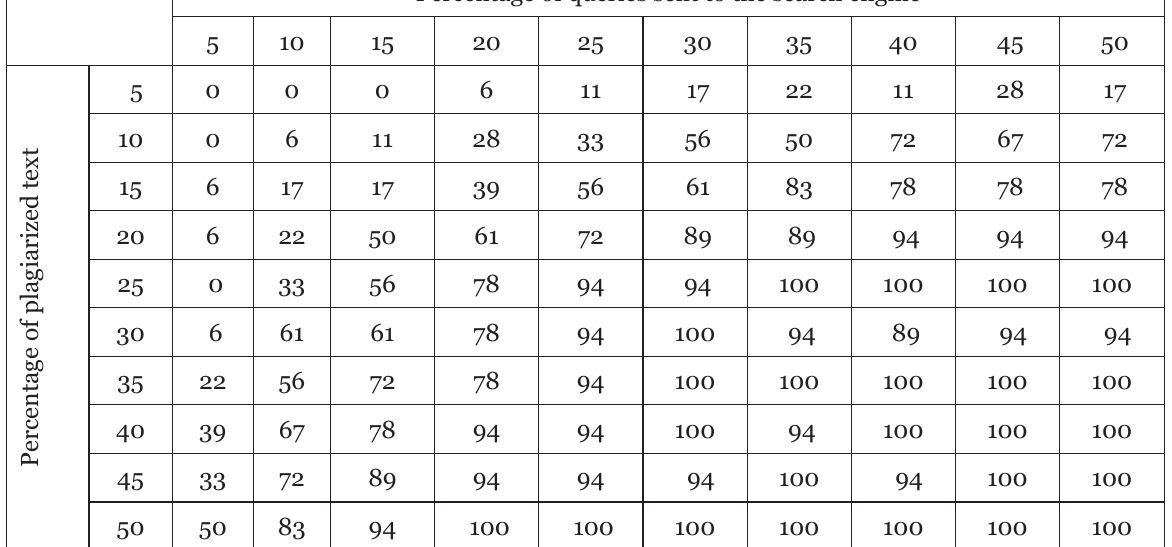
Plagiarism Detection Results on all Simulated Documents Percentage of queries sent to the search engine